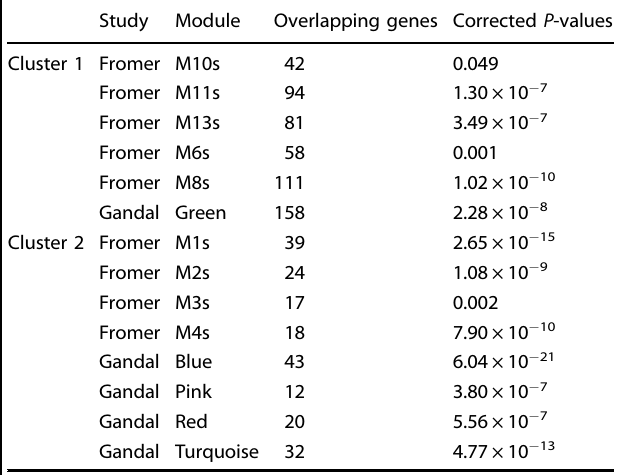
Table 3. Gene overlap between hub genes from module clusters and modules reported by Fromer et al. 7 and Gandal et al. 8 .